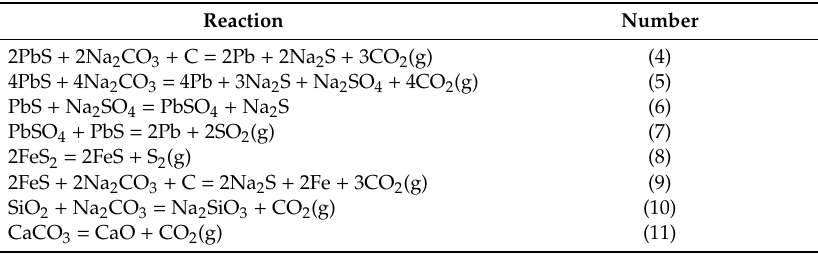
Table 3. Possible reactions and their ∆ G θ T